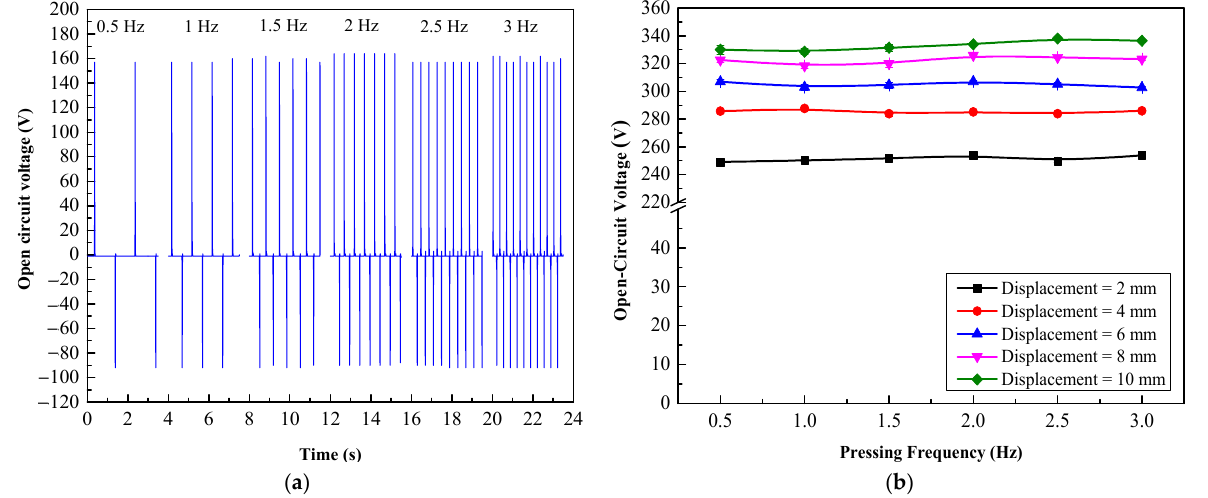
Figure 6. Effect of pressing frequency on the open-circuit voltage of TEHTB with 0.2 mm thick PTFE layer: ( a ) the open-circuit voltage at a displacement distance of 2 mm; ( b ) peak-to-peak voltage comparison while varying displacement distances at different pressing frequencies.